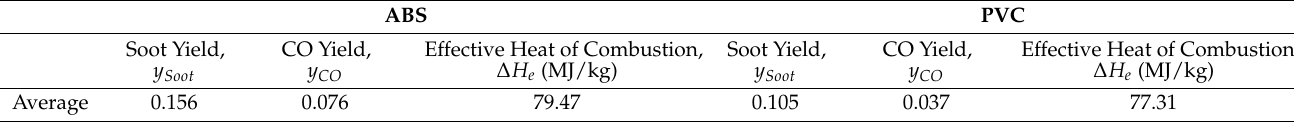
Effective Heat of Combustion, CO Yield, Soot Yield, ∆ H y CO y Soot e (MJ/kg)